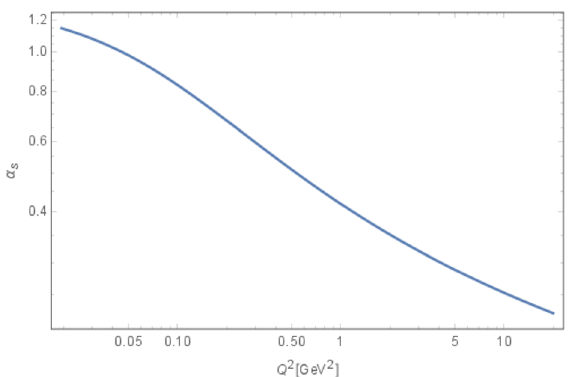
Figure 1 . Walking of the strong coupling to a fixed value at origin according to